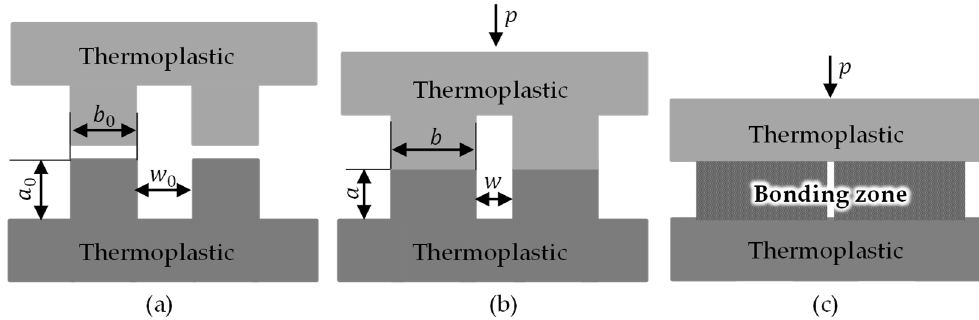
Figure 5. Schematic illustration of the consolidation model of thermoplastics, based on [22] with the process steps: no contact ( a ), intimate contact ( b ) and autohesion ( c ).